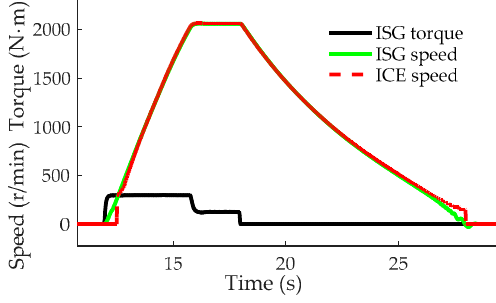
Figure 8. System speed and torque.